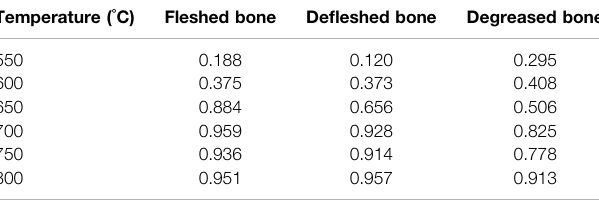
TABLE 4 | Crystallinity index values of three pretreated bones (duration: 120 min). Temperature ( ° C) Fleshed